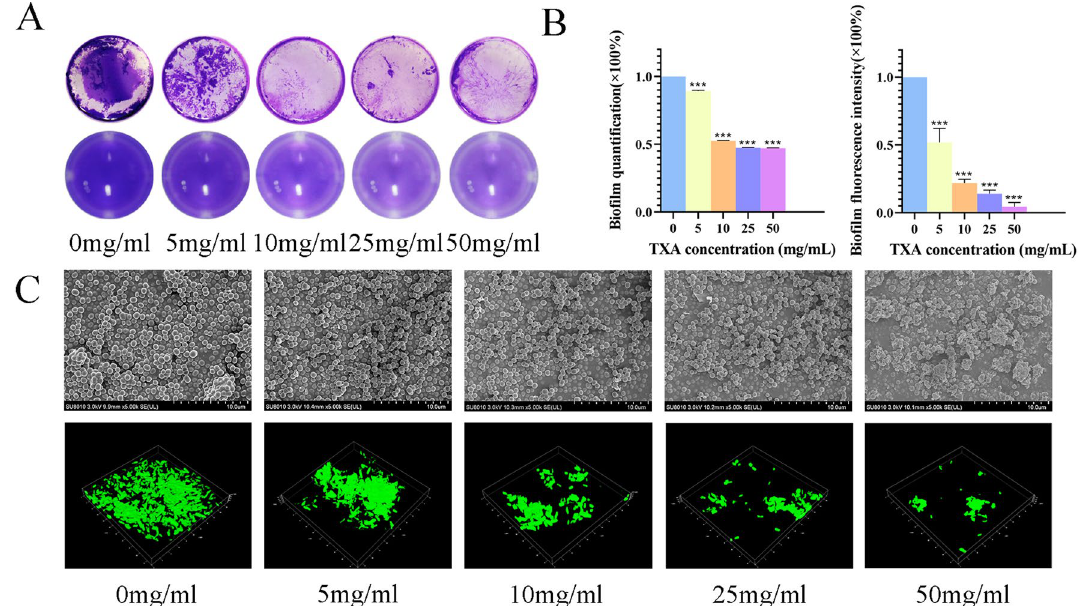
Figure 2. ( A ) The crystal violet staining results of biofilms after culturing with TXA at different concentrations for 36 h. ( B ) Biofilm quantification (left) of crystal staining and fluorescence intensity quantification (right) of CLSM after treatment with TXA at different concentrations for 36 h. ( C ) SEM (above) results of USA300 biofilm and CLSM (below) results of ATCC43300 biofilm after culturing with TXA at different concentrations for 36 h. The results in ( B ) are presented as the mean of three independent experiments of crystal staining and CLSM and analysed by one-way ANOVA (* p < 0.05 indicates statistical significance).